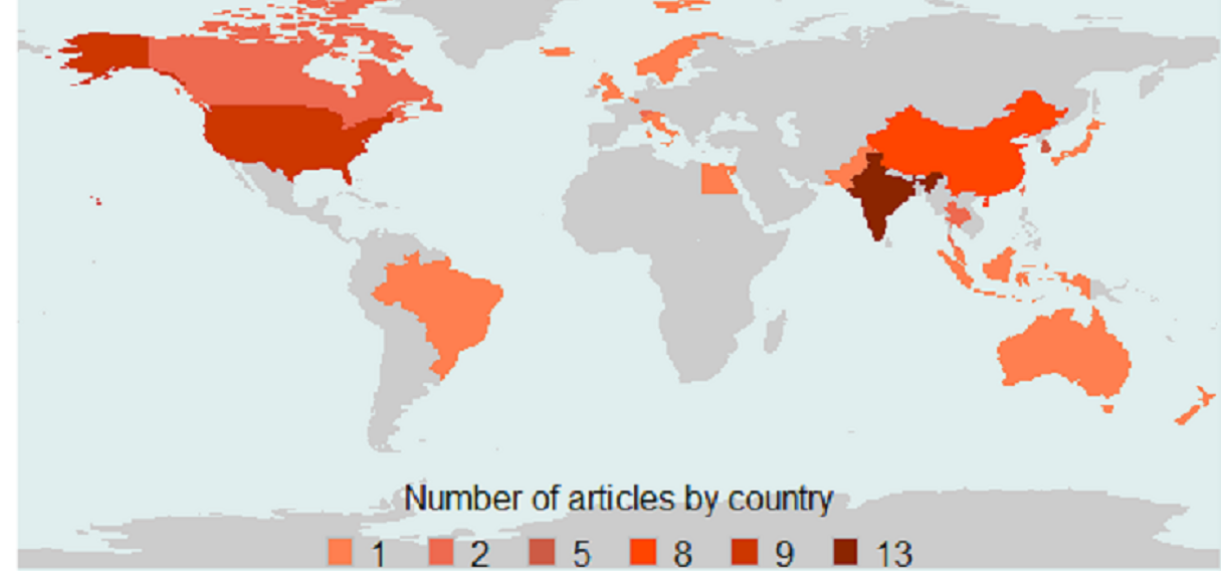
Figure 4. Distribution of articles published by geography. The number of articles refers to the total number of articles selected for the final